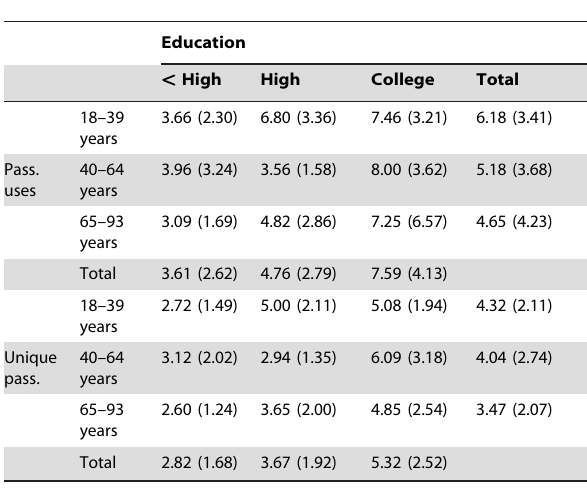
Table 2. Mean number of password uses and unique passwords according to age and